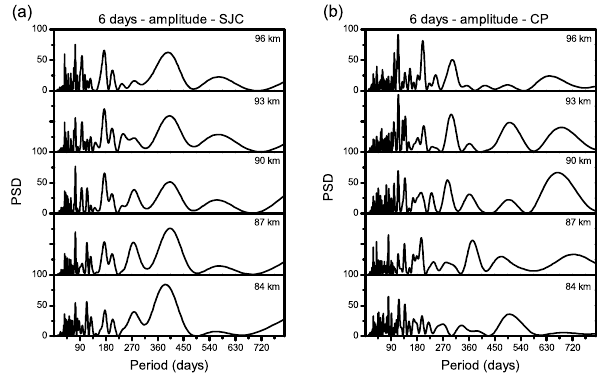
Figure 8. Lomb–Scargle periodograms obtained from amplitudes Fig. 8. Lomb-Scargle periodograms obtained from amplitudes of the 6.5-day oscillations for the zonal winds obtained on (a) Cariri and (a) of the 6.5-day oscillations for the zonal winds obtained over (a) C. Paulista for altitudes between 84 km and 96 km. Cariri and (b) C. Paulista for altitudes between 84km and 96km. Figure 9. Band-passed hourly zonal winds over Cariri (blue dotted line), for the years 2004 to 2008, and over C. Paulista (solid black line), for the years 2002 to 2008, at 90km. The passband limits used Fig. 9. Bandpassed hourly zonal winds over Cariri (blue dot), for the years 2004 to 2008, and over C. Paulista (black line), for the years 2002 was 8 to 24 days, centered on 16 to 2008, at 90 km. The pass-band limits used was 8 to 24 days, centered on 16 days.